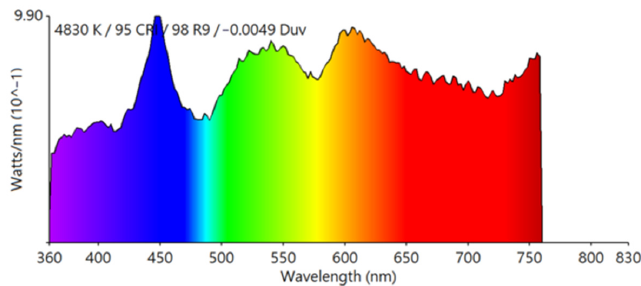
Figure 8. Ambient light spectrum for the typing test.